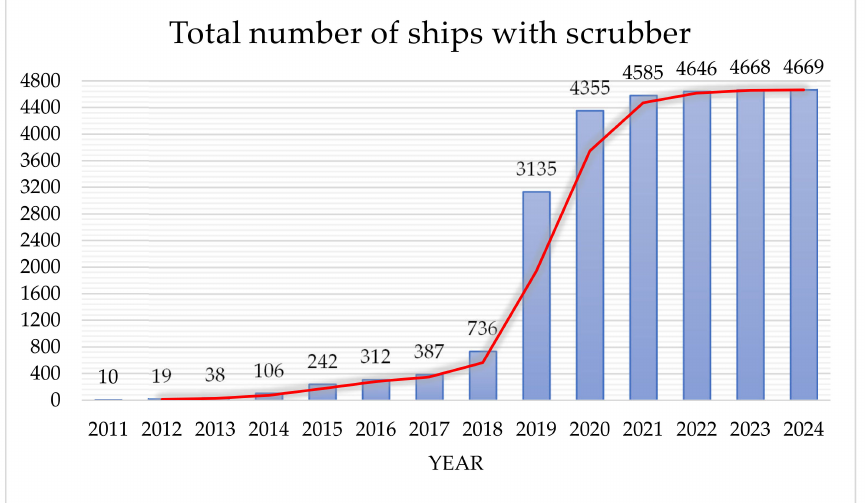
Figure 1. The rise in the total number of ships with scrubbers (in operation and on order)